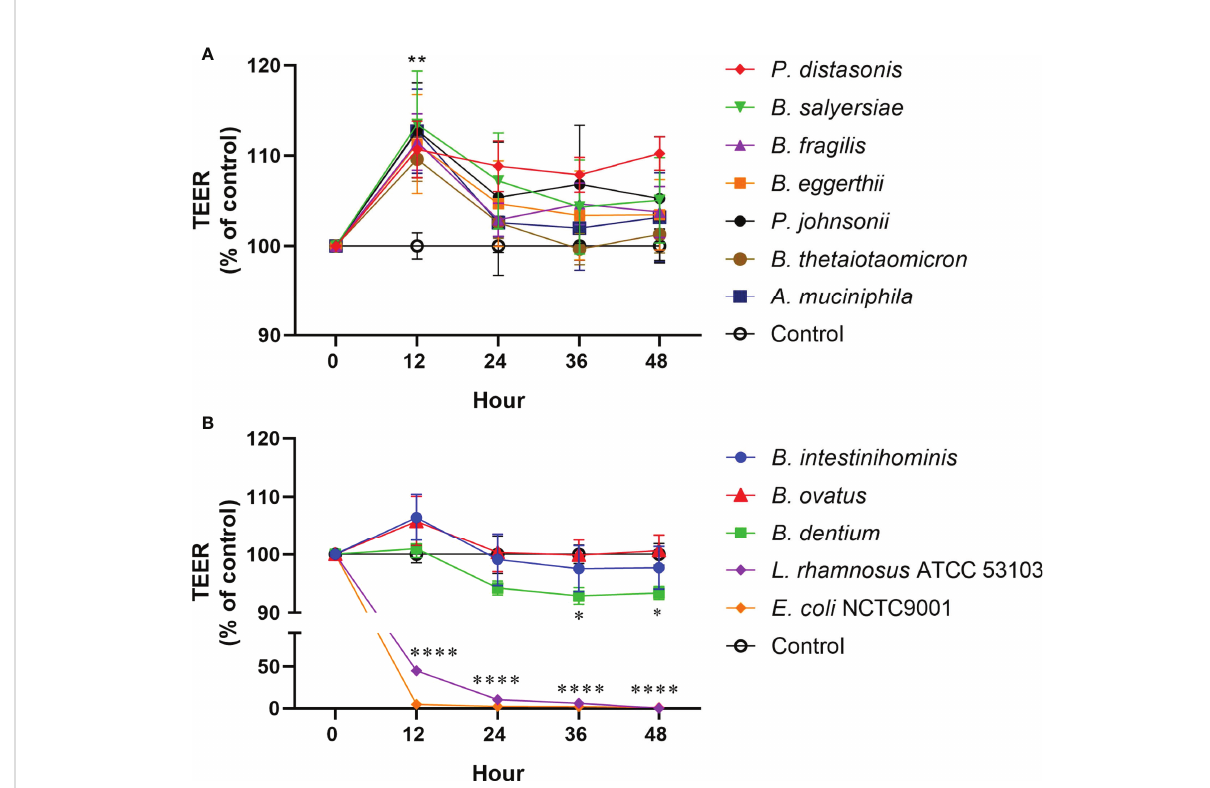
FIGURE 4 Effect of mucin-degrading gut commensals on the development of the TEER of Caco-2 monolayer. Changes in the TEER values of the Caco-2 cell monolayers co-cultured with bacteria were monitored over 48 h experiment. Cell monolayers without bacteria incubation were used as the control group and the TEER values were normalized to 100%. *p < 0.05, **p < 0.01, ****p < 0.0001 treated groups vs. control group. Error bars represent the standard deviation of the mean values from at least three replicates. Signi fi cance was determined by one-way ANOVA